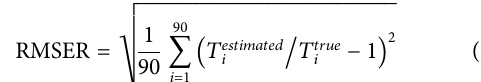
Figure 3E , for the same reason that the estimation accuracy for c is higher than that for k v .